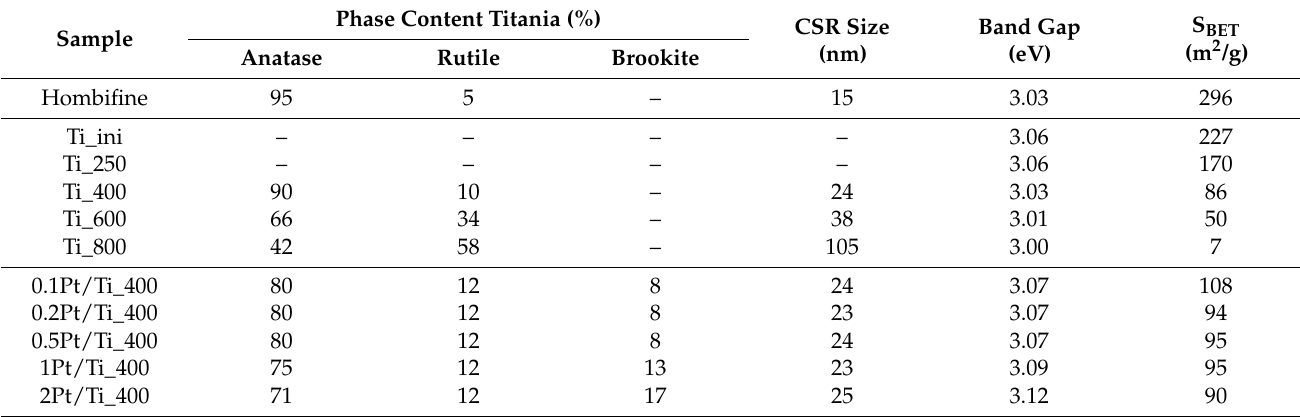
Table 1. Phase content, crystallite size, band gap value, specific surface area of PLAL samples.